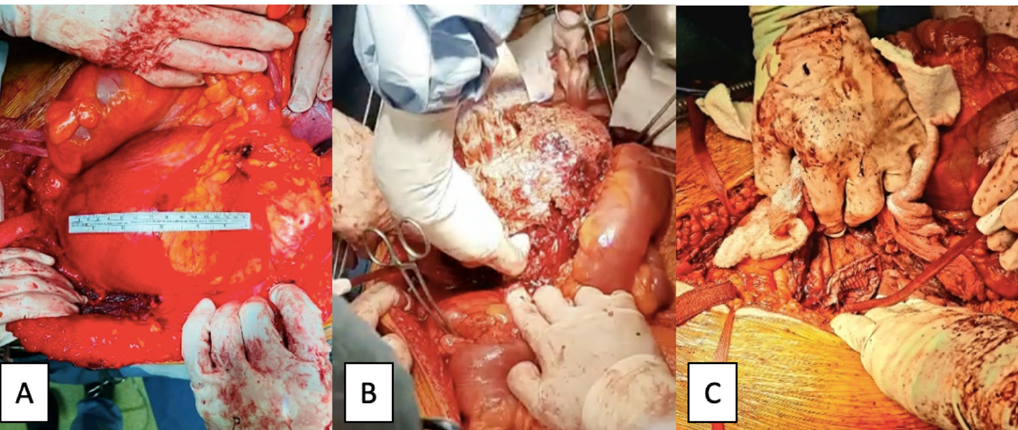
Figure 6. Intraoperative images: ( A )—pseudoaneurysms content; ( B )—patch angioplasty ( C )—left common iliac artery pseudoaneurysm.